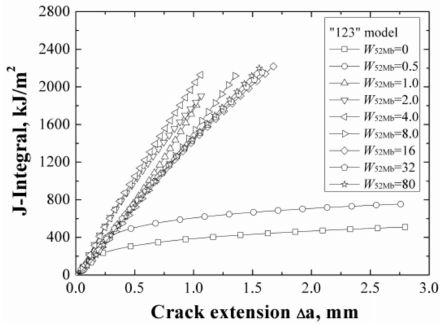
Figure 8. The J -resistance curves of different “123”